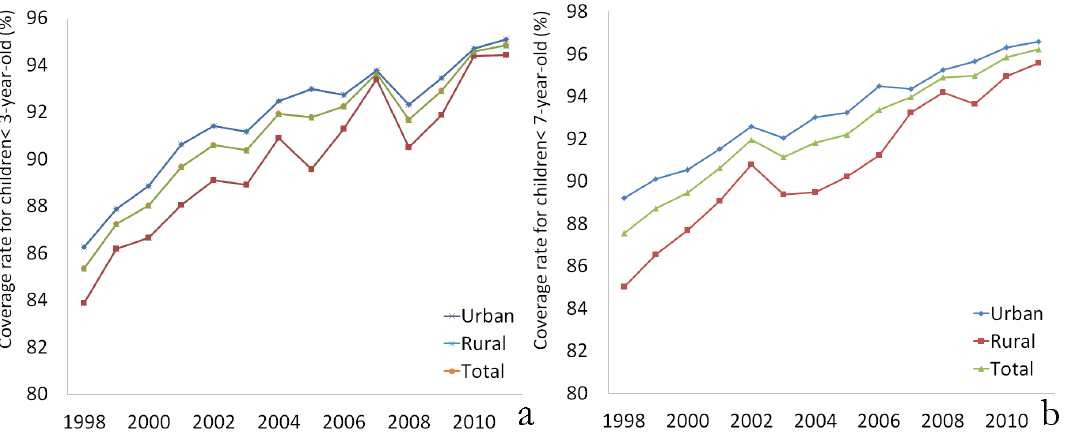
Figure 1. The primary health care coverage rates. (a) For children under 3 years old; (b) For children under 7 years old. doi:10.1371/journal.pone.0062854.g001 PLOS ONE |